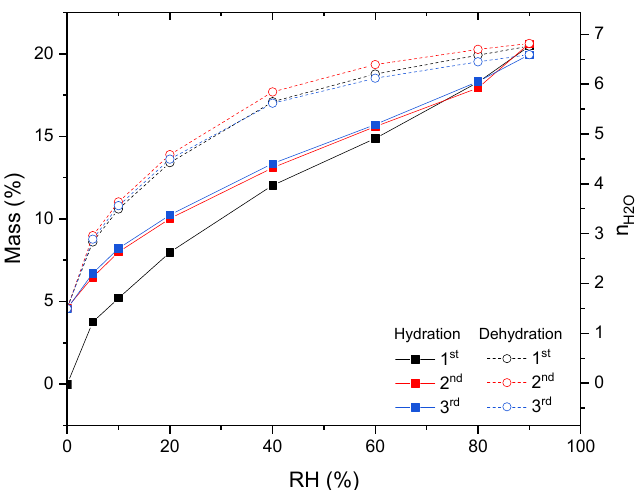
Figure 8. Hydration–dehydration cycles of CaHS through a thermogravimetric dynamic vapor system under isothermal conditions (T = 30 °C) and varying the RH. Before the first hydration, the material was dehydrated at 150 °C under a vacuum for 2 h.